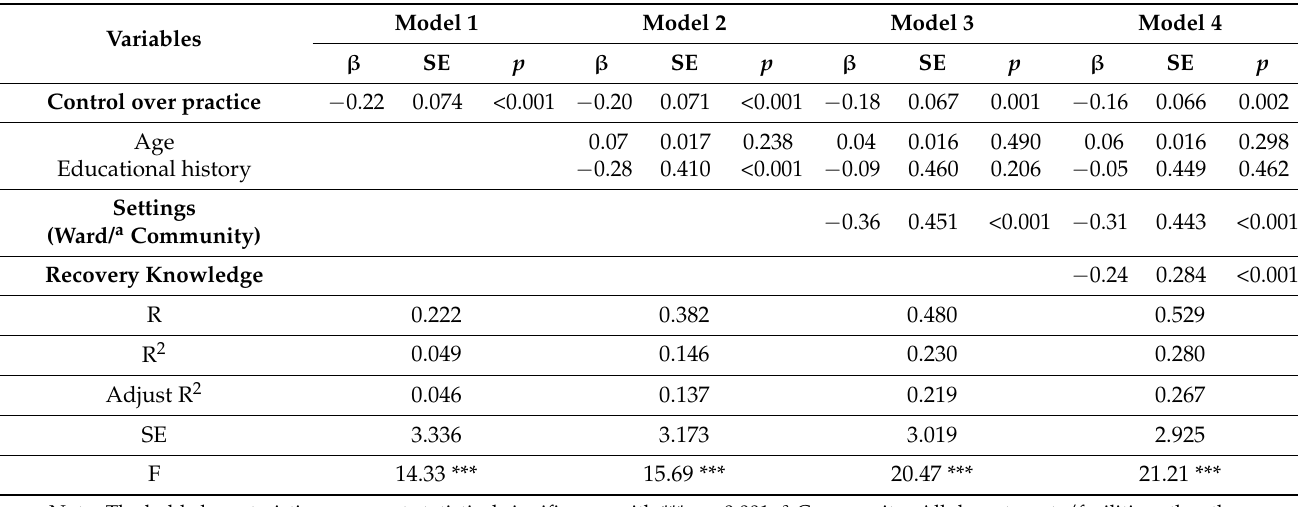
Table 2. The results of hierarchical multiple linear regression model with forced entry method ( n = 279).